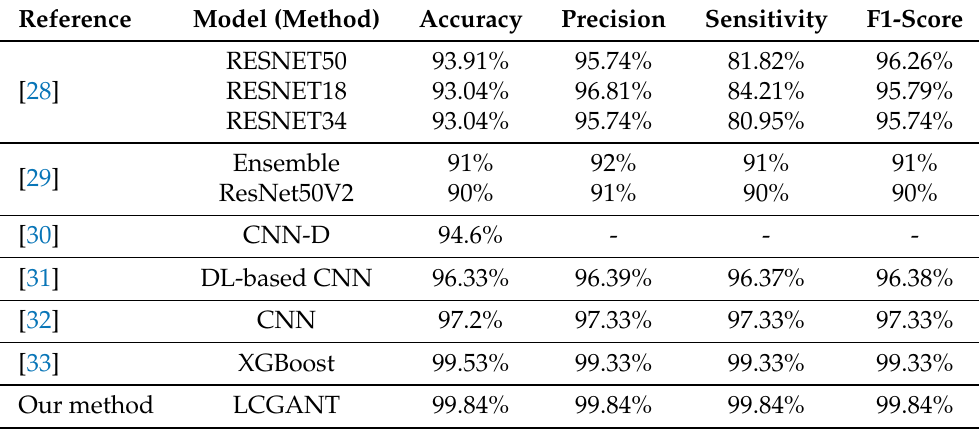
Table 6. Comparison of state-of-art